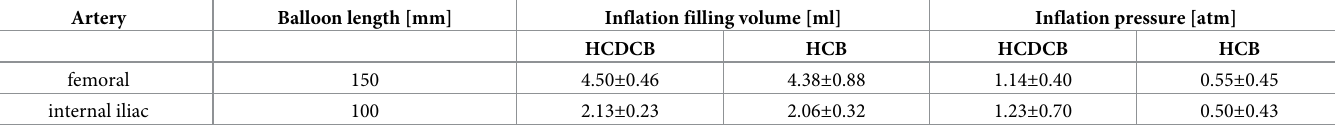
Table 2. Inflation filling volume and inflation pressure applied for hyper-compliant